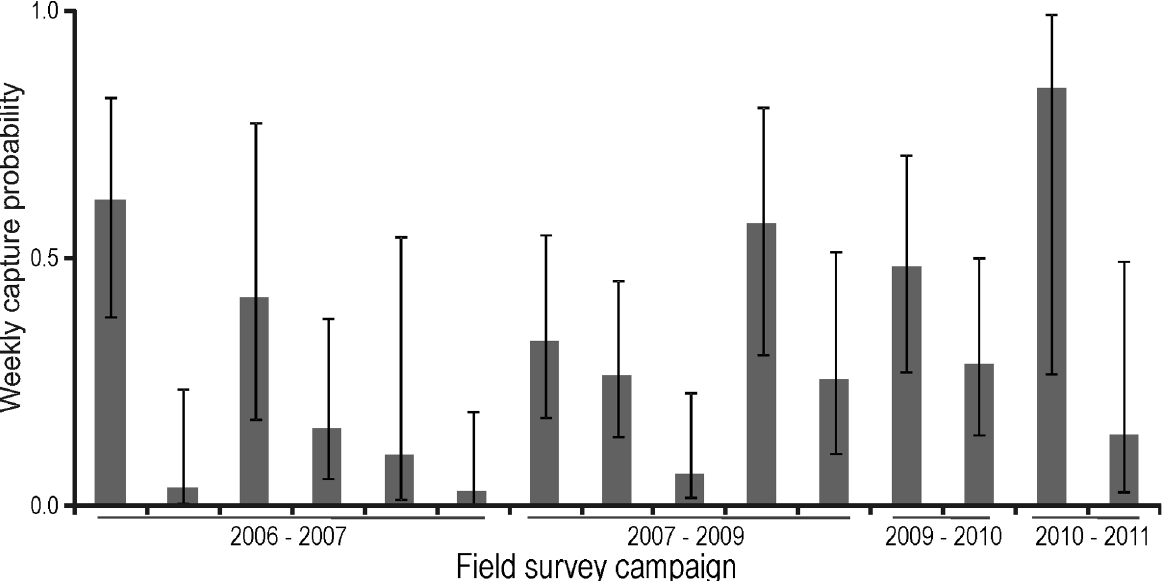
Figure 4. Mean values (± SE) of weekly capture probability ( p ) for adult Chaetophractus vellerosus for each field survey, estimated by multi-model inference based on the set of candidate CJS models. Values are presented for both sexes combined because differences in capture probability between males and females were in all cases <